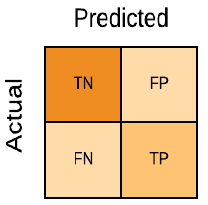
Figure 6. Confusion